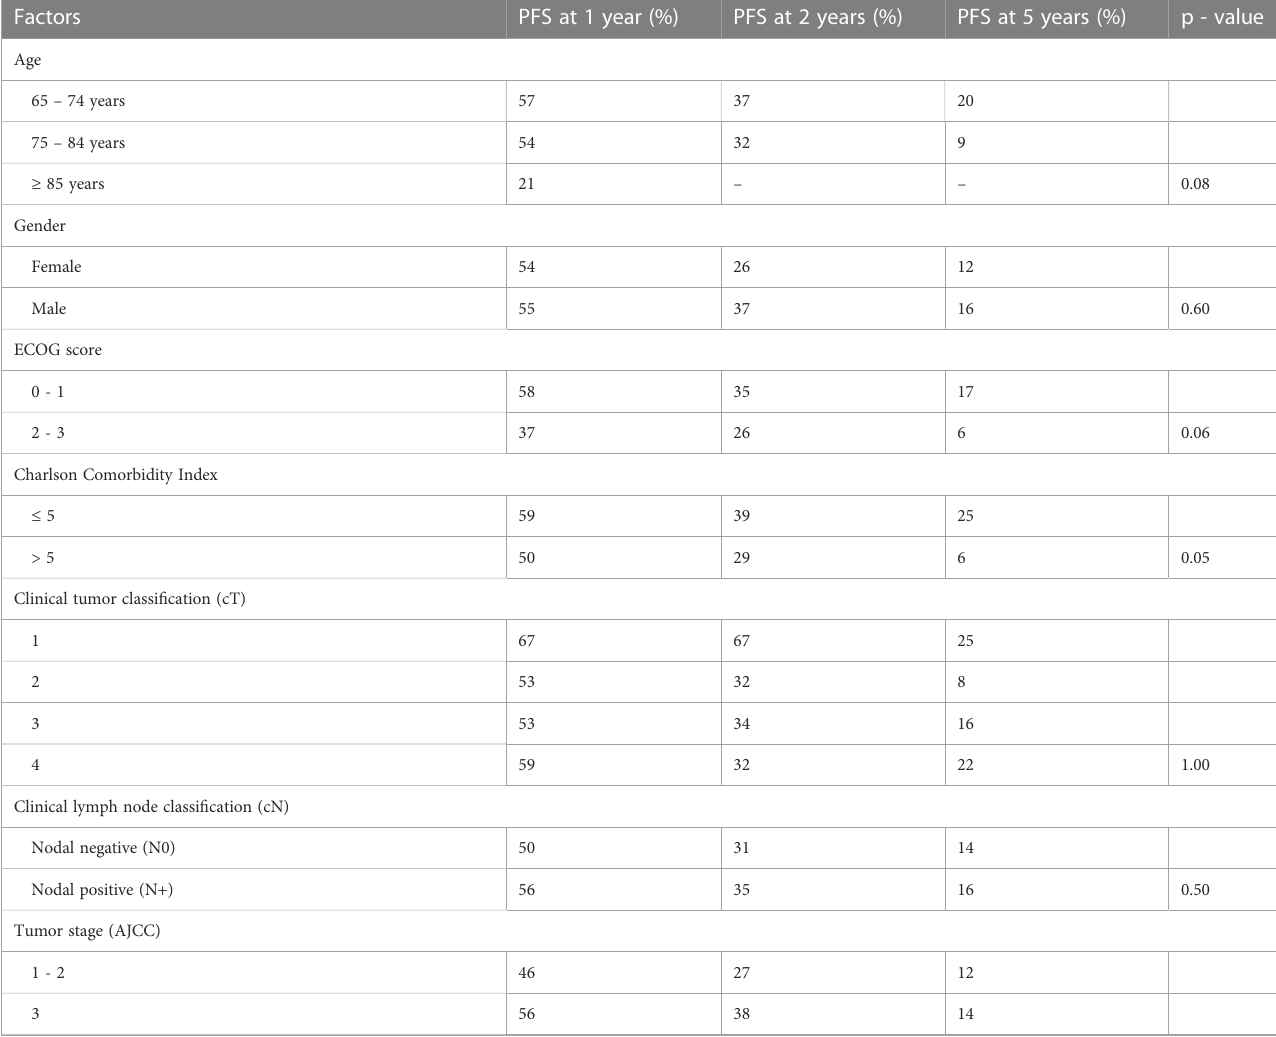
TABLE 2B Univariate analyses of potential prognostic factors for progression-free survival